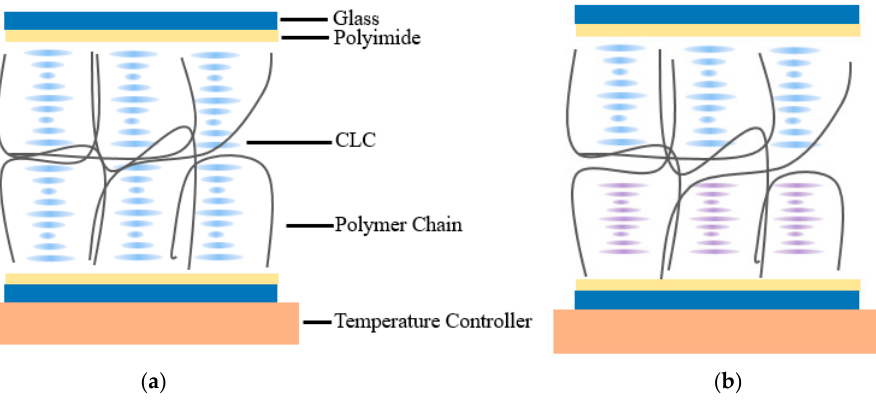
Figure 3. The mechanism illustration of the holding treatment. The cholesteric liquid crystal (CLC) pitch distribution in cell ( a ) at the holding temperature, and ( b ) at the cured temperature in the sectional polymerization process.